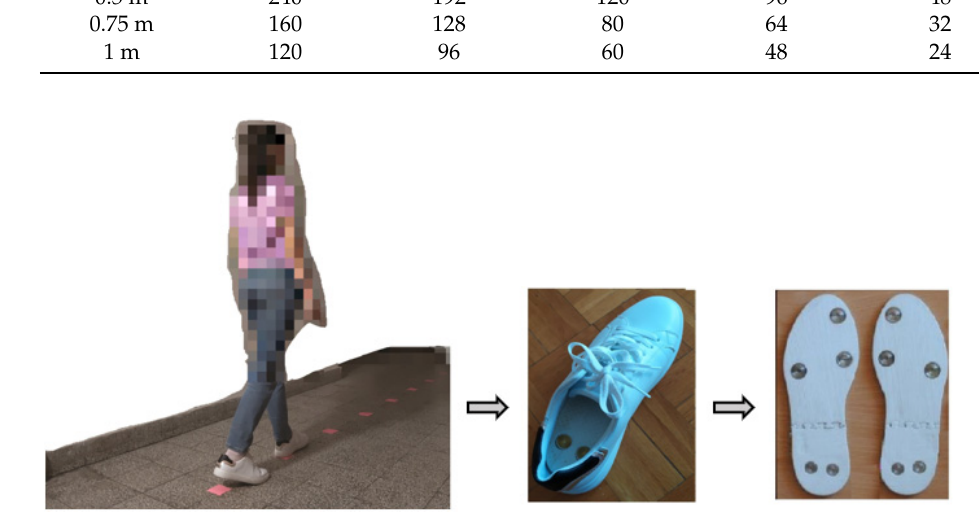
Figure 2. An example of the experimental setup.